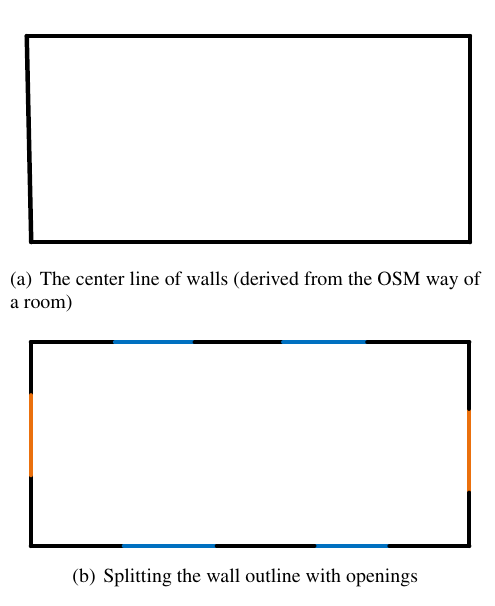
Figure 4: The extraction of walls considering openings. The brown lines represents doors. The blue lines represent windows.